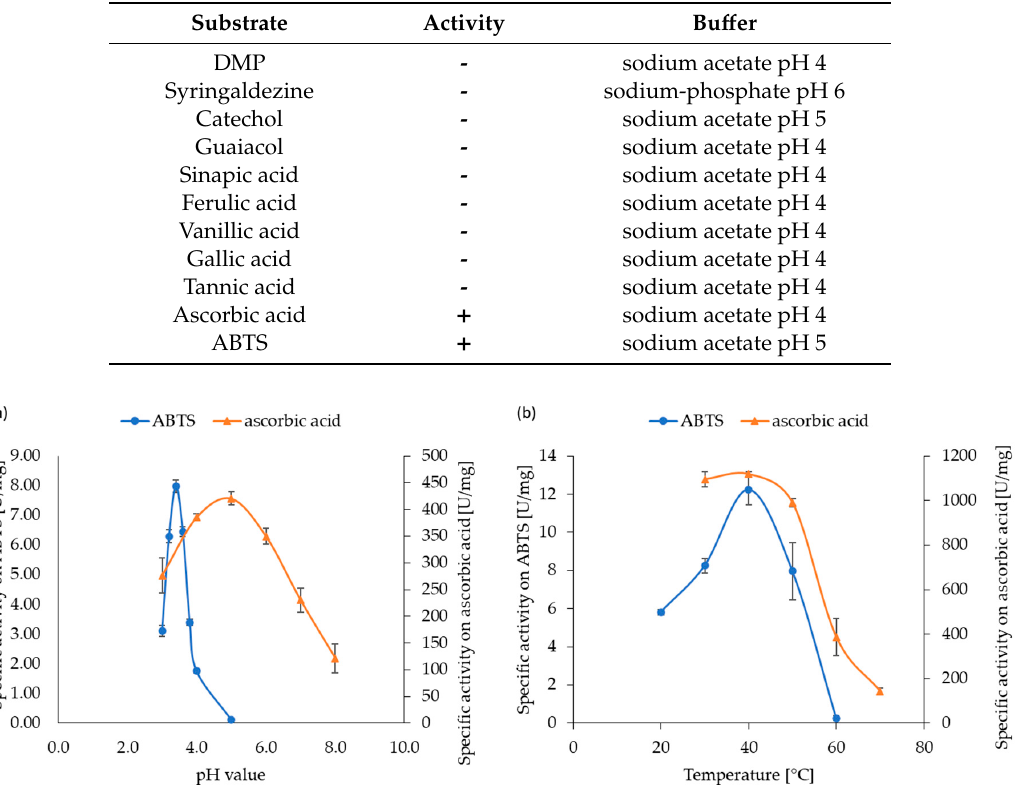
Figure 2. Redox potential of Af _AO1: Cyclic voltammogram of Af _AO1 at 10 mV · s − 1 , exhibiting an oxidation peak at 500 mV and a reduction peak at 410 mV, indicating a redox potential at 445 ± 10 mV against normal hydrogen electrode (NHE). Table 1. Substrate screening: Af _AO1 converted, of all tested substrates, only ascorbic acid and 2,2 (cid:48) -azino-bis(3-ethylbenzthiazoline-6-sulfonic acid) (ABTS). Activity was measured at conditions preferred by each substrate. Activity was determined at 25 ◦ C, except for ascorbic acid, which was measured at 30 ◦ C.